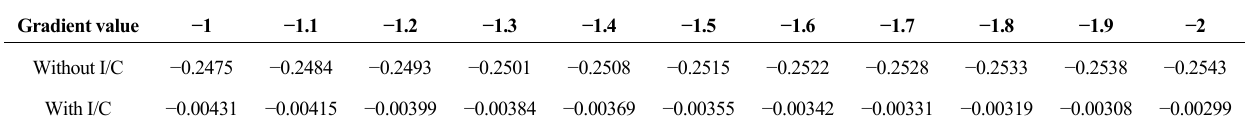
Table 3. Consumer surplus deviation index with respect to gradients of the demand curve.